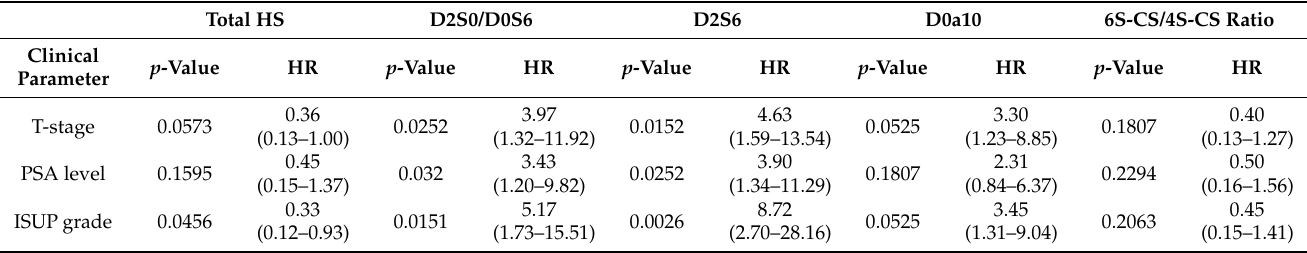
Table 1. Multivariate analysis between clinical parameters (T-stage, ISUP grade, and PSA level) and GAG motifs (total HS, D2S0/D0S6, D2S6, D0a10 relative abundance, and 6S-CS/4S-CS ratio), FDR controlled p -values, and hazard ratios with 95% confidence intervals are presented. See Figure 1 for resolving the GAG structure